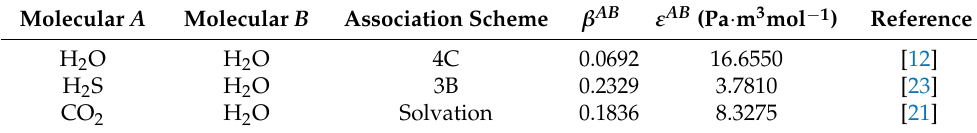
Table 2. Association parameters between acidic gas molecules and water molecules.